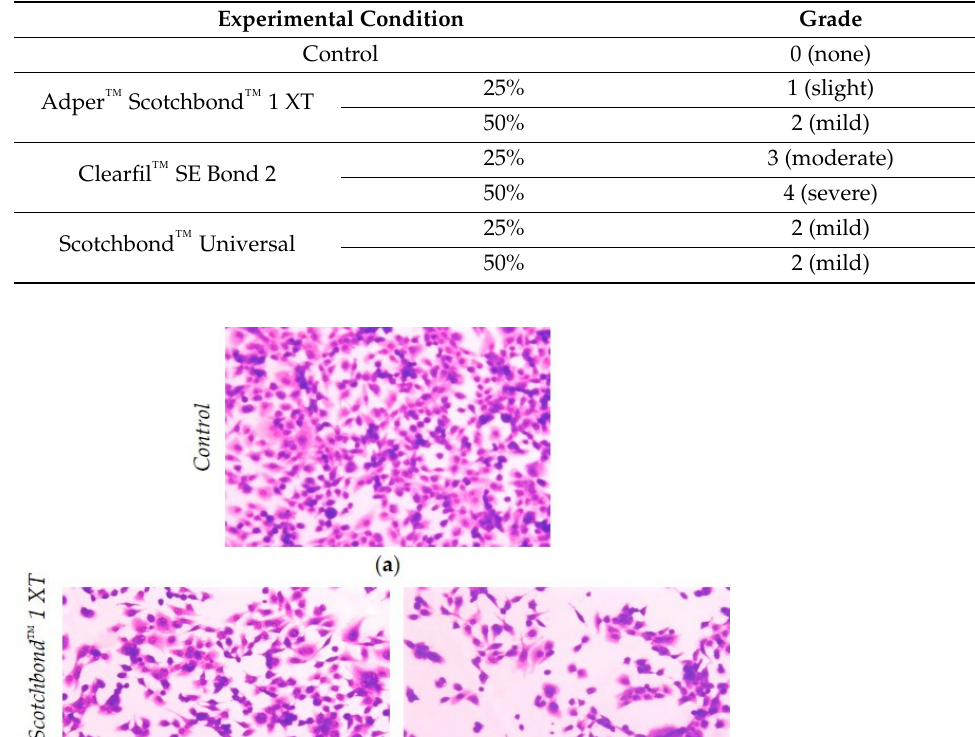
Table 3. Qualitative cytotoxicity assessment of the cell cultures submitted to the adhesive extracts.